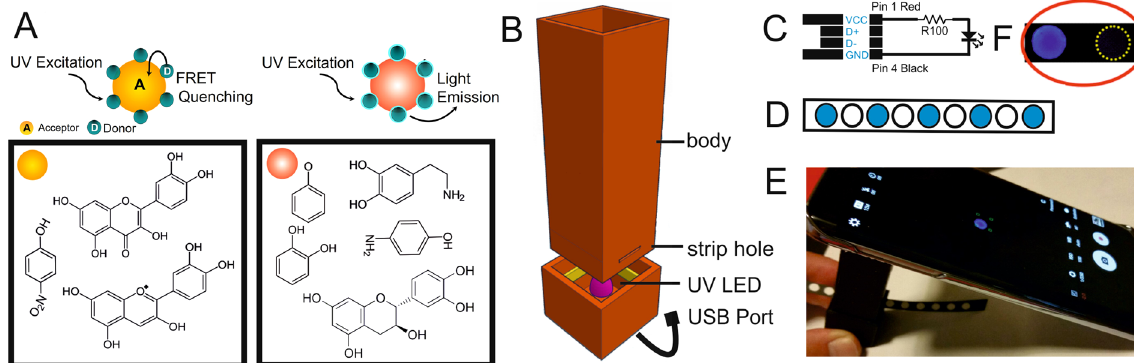
Figure 1. Schematic representation of the fluorescence quenching of Quantum Dots in the presence of an analyte by the FRET phenomenon. ( A ) Examples of phenolic compounds susceptible of producing GQDs quenching and those unable to produce it are denoted with a yellow and red circle, respectively. ( B ) Schematic representation of a 3D-printed device with its different parts. ( C ) The electric circuit of the 365 nm UV LED connected to the male USB port. ( D ) Scheme of a nitrocellulose paper strip with wax-printed circular areas. ( E ) Image of the sensing platform where the fluorescent spot is observed in the middle of a mobile phone screen. ( F ) Picture of the sensing area of a yes/no (ON/OFF) typical